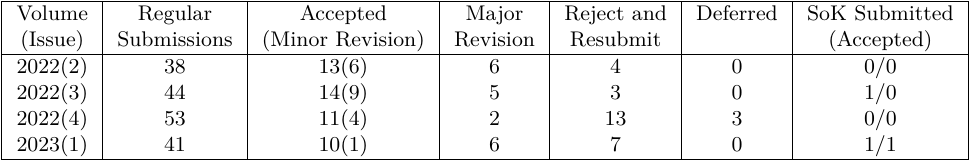
Table 1: Submission statistics for issues 2022(2), 2022(3), 2022(4), and